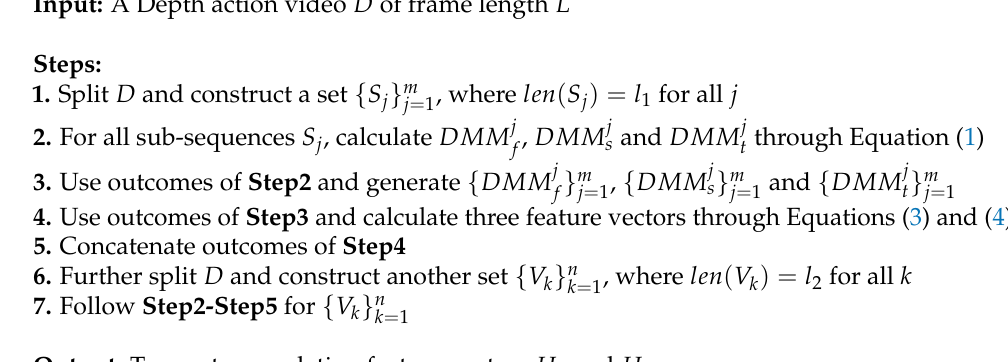
Algorithm 1 Algorithm for feature vector